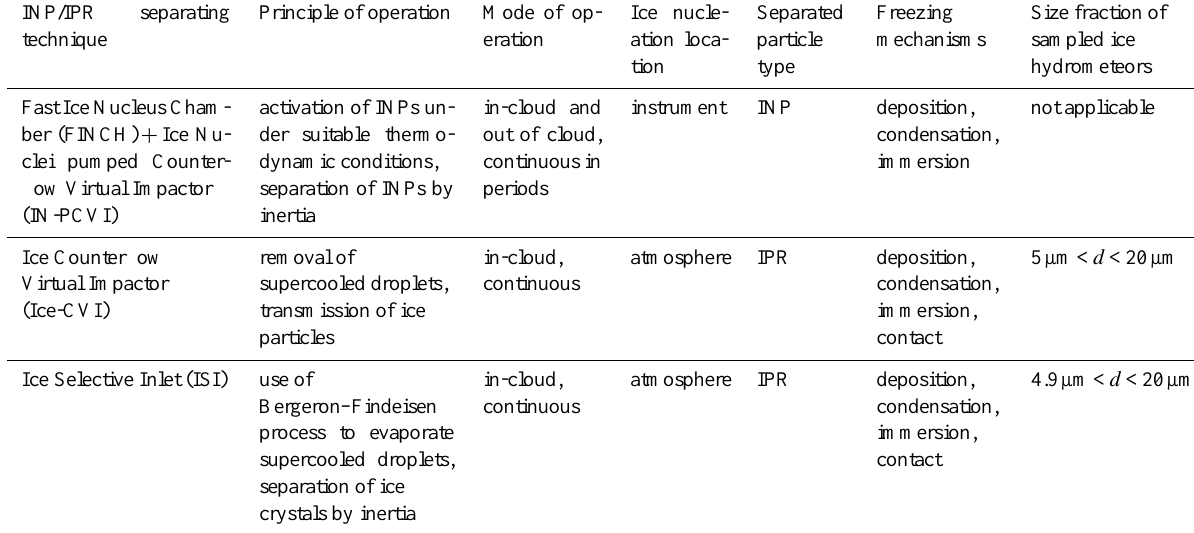
Principle of operation Mode of op-